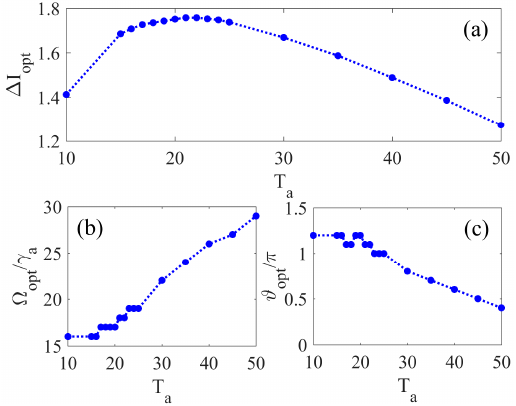
Figure 6. Dependence of ∆ I opt ( a ), as well as the corresponding dependence of Ω opt / γ a ( b ) and ϑ opt / π ( c ) on the absorber Mössbauer thickness, T a . Maximum of ∆ I opt ( T a ) is achieved at T a = T ∗ a (cid:39) 21. At this value, Ω opt ( T ∗ a ) / γ a ≡ Ω ∗ opt / γ a (cid:39) 18, and ϑ opt ( T ∗ a ) ≡ ϑ ∗ opt (cid:39) 1.1 π